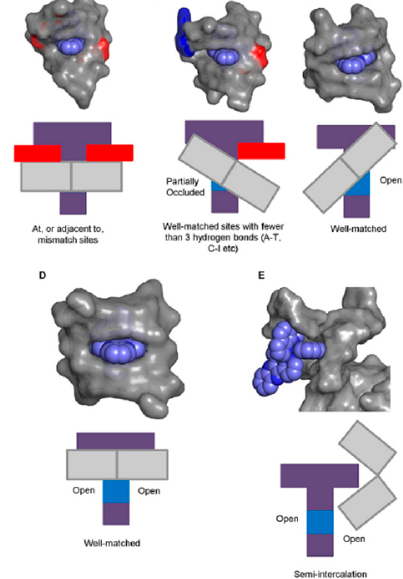
Figure 6. Five possible binding modes for Δ -[Ru(phen) 2 (dppz)] 2+ to DNA. ( A ) The complex binds at, or adjacent to, a mismatch site. ( B ) Insertion into well-matched sites with less than three H-bonds between the bases. ( C ) Canted intercalation into a well-matched base pair leaves one dppz nitrogen atom entirely exposed to solvent. ( D ) Model for intercalation by a Δ enantiomer at a 5 ′ -AT / AT-3 ′ step. ( E ) Semi-intercalation by an ancillary ligand into the DNA duplex, exposing both of the phenazine nitrogen atoms to the solvent. Reprinted with permission from the authors of [54]. Copyright © 2016, Oxford University